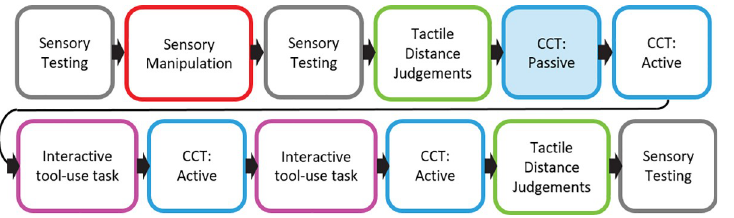
Fig 2. Procedure for each experimental session. During the sensory manipulation phase the experimenter applied a capsaicin cream (pain condition) or warm-up gel (active placebo condition) to the participant’s dominant arm, or there was no manipulation (neutral condition). During the passive stage (set 1) of the Crossmodal Congruency task (CCT) the experimenter changed the tools between the crossed and uncrossed positions. During the active stages